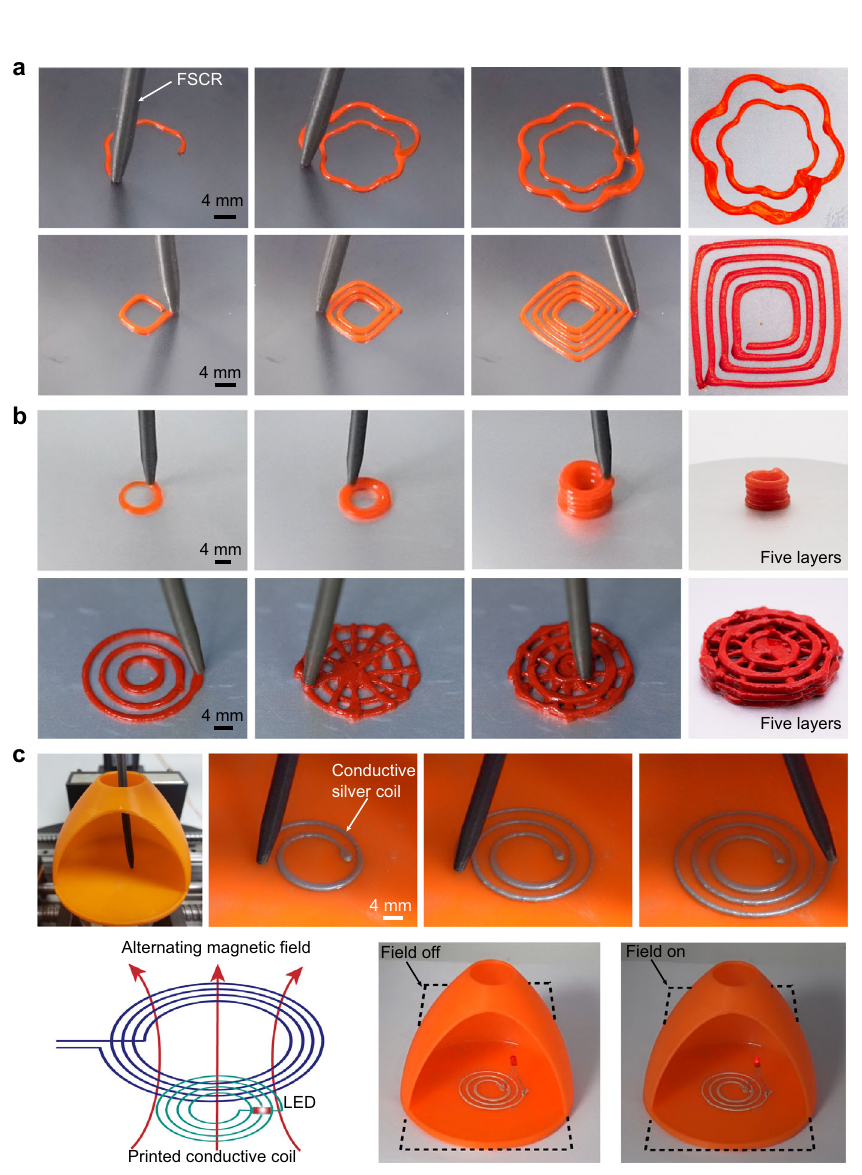
Fig. 4 Direct ink printing by an FSCR. a Demonstration of FSCR printing with viscoelastic materials (PDMS-1700 and Eco fl ex composite) into different patterns such as a fl ower with six petals and a square spiral. b Printing 3D fi ve-layered tube and scaffold with viscoelastic materials. c Upper panels: Images of experimental demonstration of printing functional device. An LED was placed as an energy-dissipating element on a conductive silver ink coil after printing. Bottom panels: left, schematic of the printed wireless device that powered a surface-mounted LED under an alternating magnetic fi eld from an electromagnetic coil (power: 1600 watts) at a distance of 10 mm. Middle: the actual circuit. Right: LED activation upon imposing and alternating magnetic fi